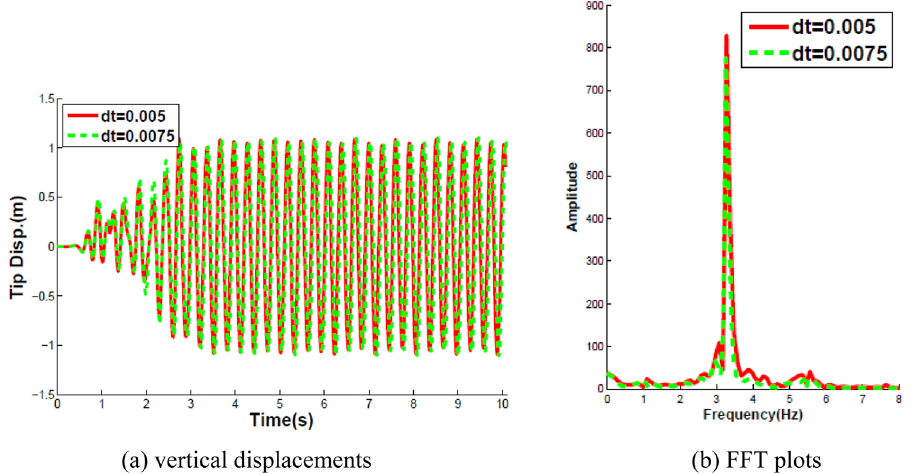
Figure 7. Curves of the vertical displacements of the oscillating tip of the beam in time and